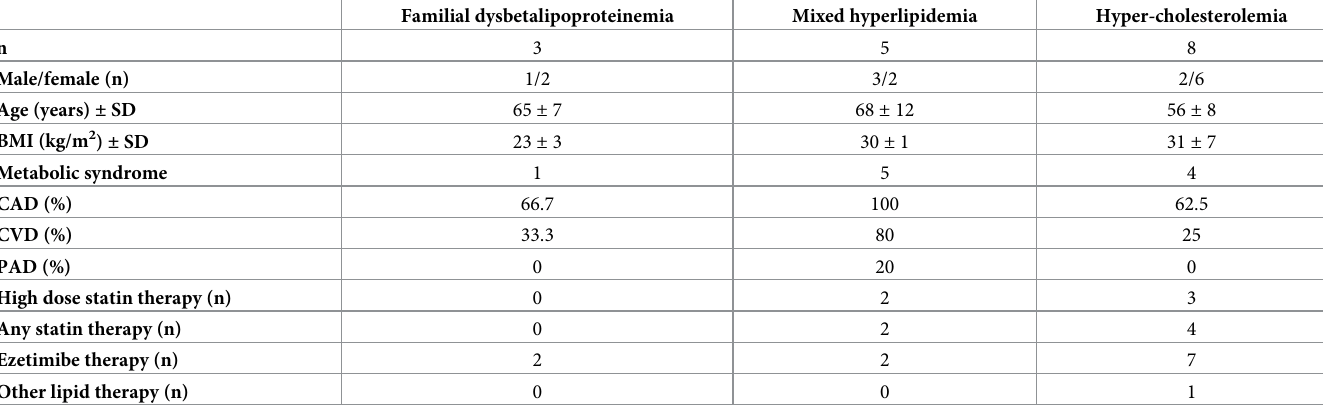
Table 1. Characteristics of study participants. Familial dysbetalipoproteinemia Mixed